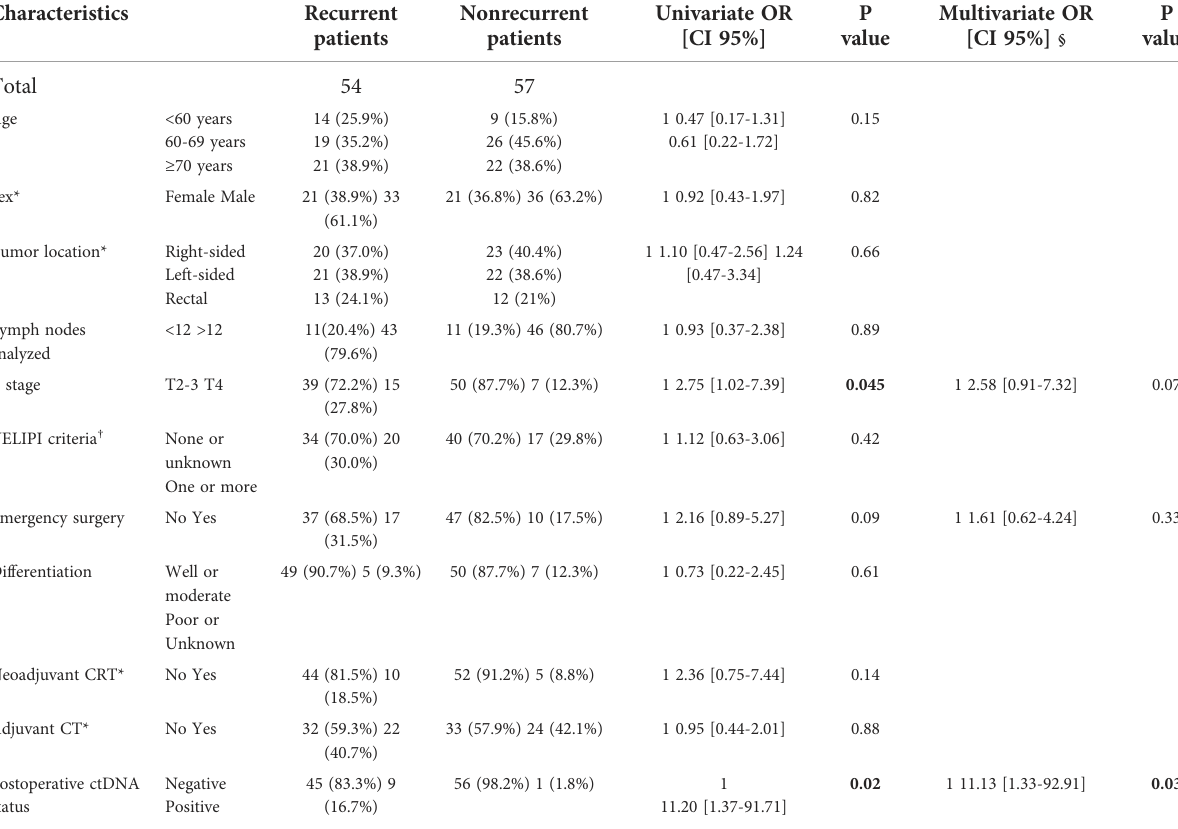
*Nonrecurrent patients were initially matched with recurrent patients on these factors. § Multivariate regression model includes variables with a p value less than 0.1 in univariate analysis † VELIPI criteria include vascular, lymphatic and/or perineural invasion. CRT, chemoradiotherapy; CT, chemotherapy; ctDNA, circulating tumor DNA. Bold values correspond to p values lower than